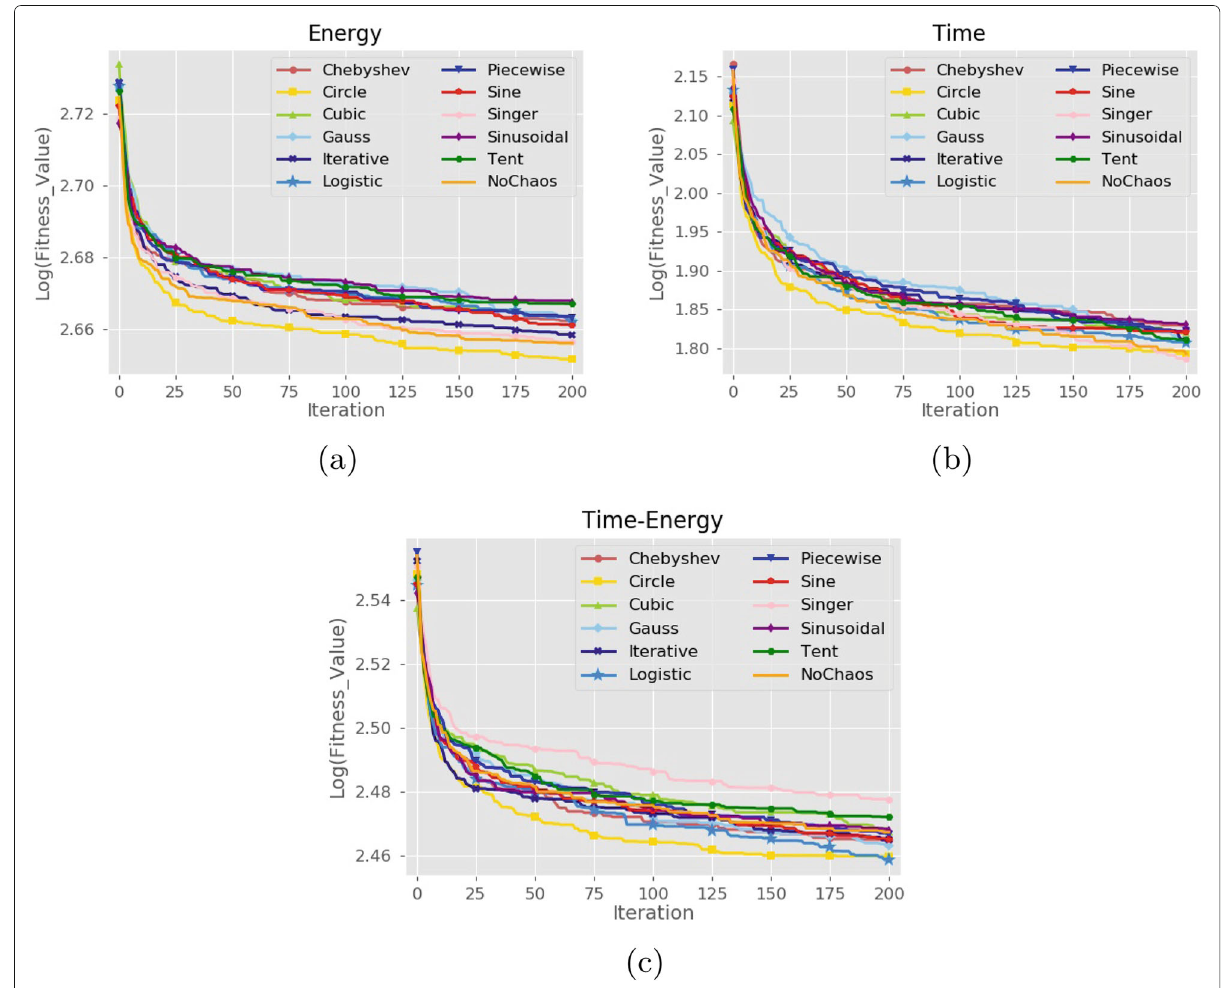
Fig. 7 Performance comparison of 11 chaotic maps for (cid:6) r